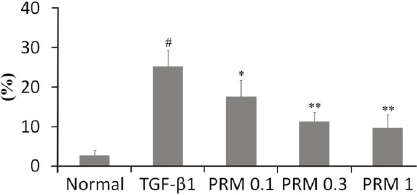
Figure 3. Effects of pulmonary rehabilitation mixture (PRM) on cell apoptosis in type I alveolar epithelial cells (AT1). The apoptosis of AT1 was detected by flow cytometry when they were treated with the supernatant (5 ng/mL) of transforming growth factor (TGF)- b 1-stimulated A549 cells for 4 h. Data are reported as means±SD. # P , 0.01 vs the normal group; *P , 0.05, **P , 0.01 vs TGF- b 1-stimulated supernatant group (one-way ANOVA followed by Dunnett’s test).